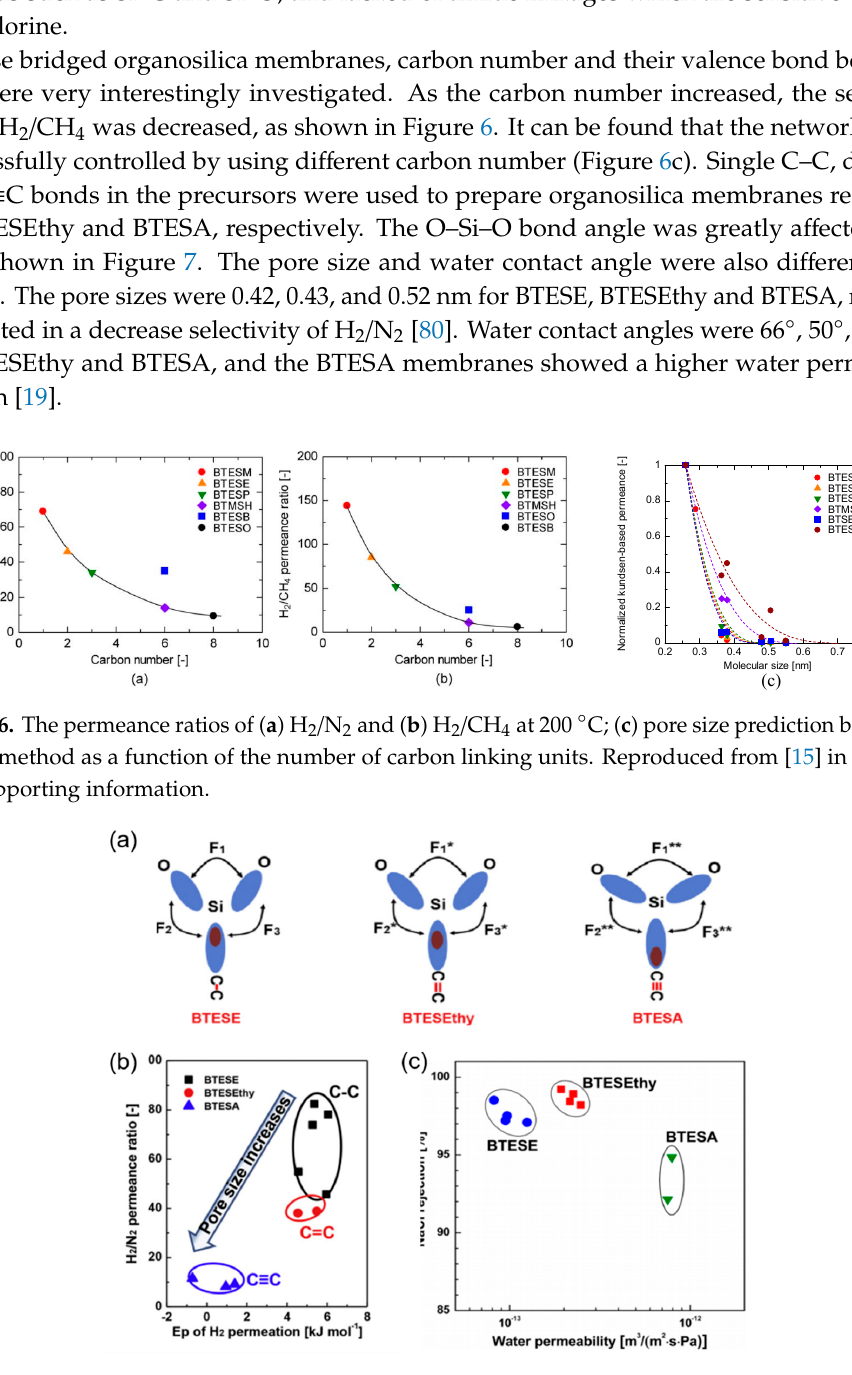
Figure 7. ( a ) Bonding structure model, ( b ) H 2 /N 2 permeance ratio at 200 °C and ( c ) water permeability versus salt rejection (25 °C, 1.15 MPa, and 2000 ppm of NaCl) for BTESE, BTESEthy, and BTESA membranes. Reproduced from [19,80] .